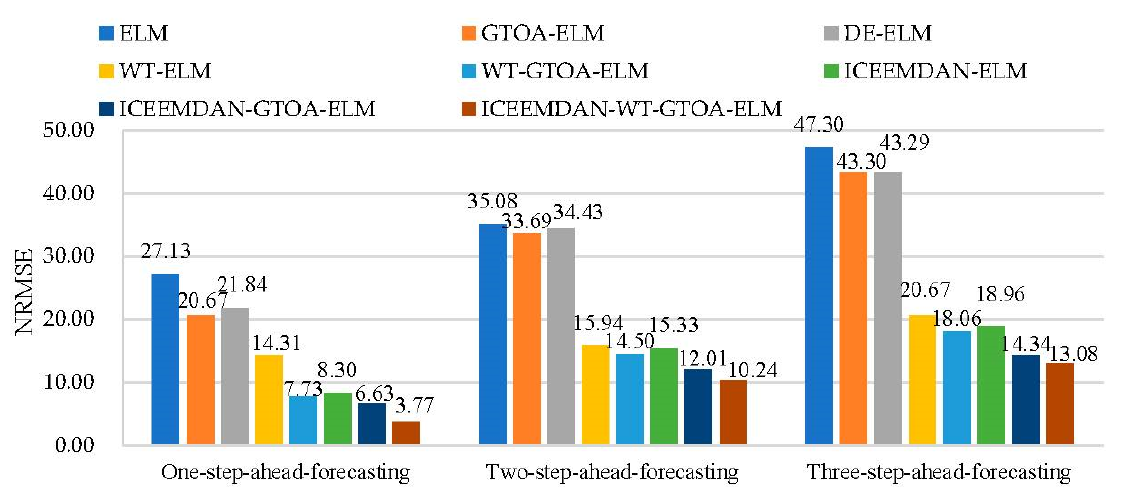
Figure 6. Normalized root mean square error (NRMSE) of PM10 forecasting.